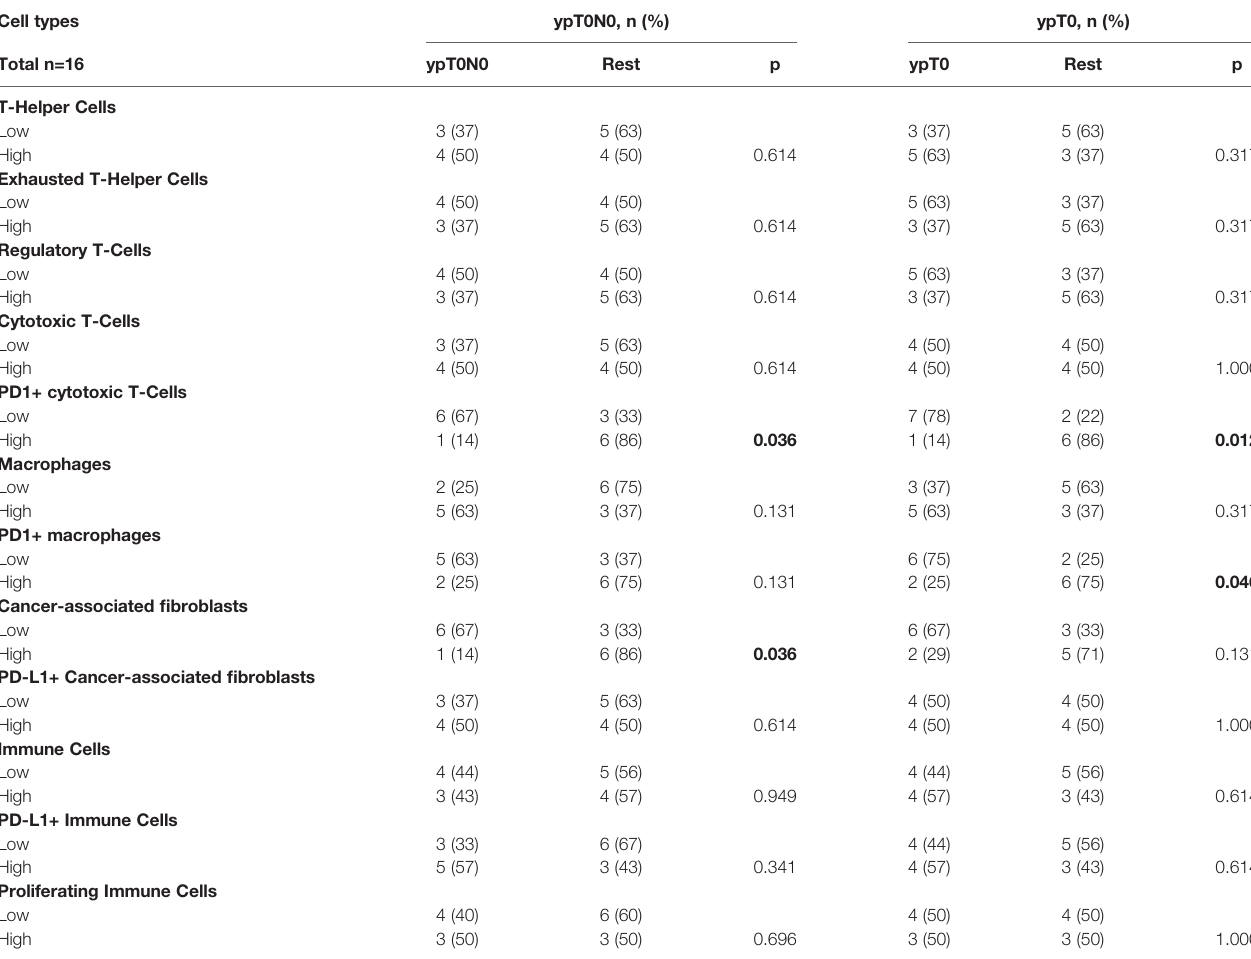
TABLE 3 | Association of pre-treatment immune cell in fi ltration and cells of the tumor microenvironment with response to neoadjuvant chemoradiotherapy. Cell